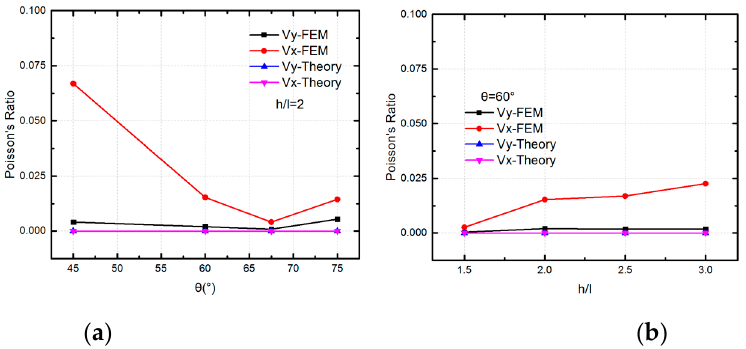
Figure 13. The FEM results and analytical results of Poisson ratios of the unit cell in the x - and y - directions ( a ) Poisson ratios with di ff erent θ ; ( b ) Poisson ratios with di ff erent h